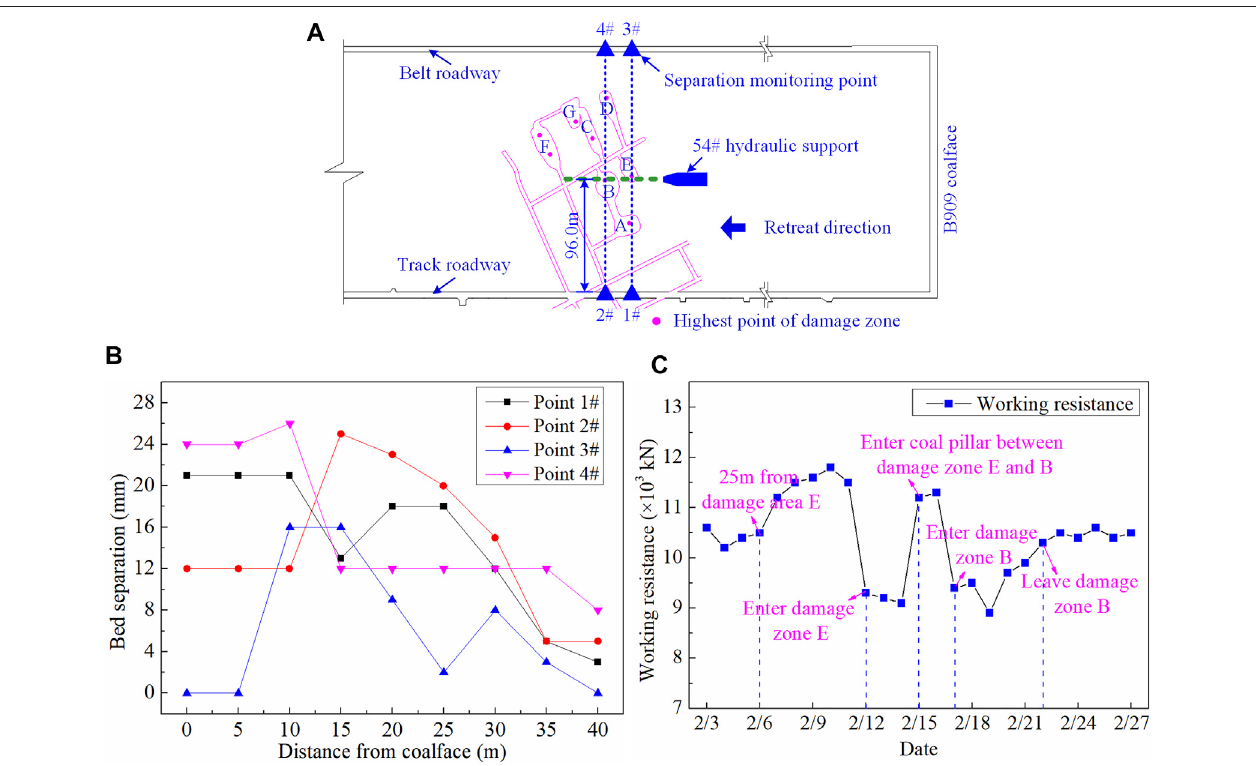
FIGURE 12 | Location of monitoring points and fi eld measurement results: (A) location of monitoring points relative to Panel B909; (B) bedding plane separation; (C) working resistance of hydraulic chocks.